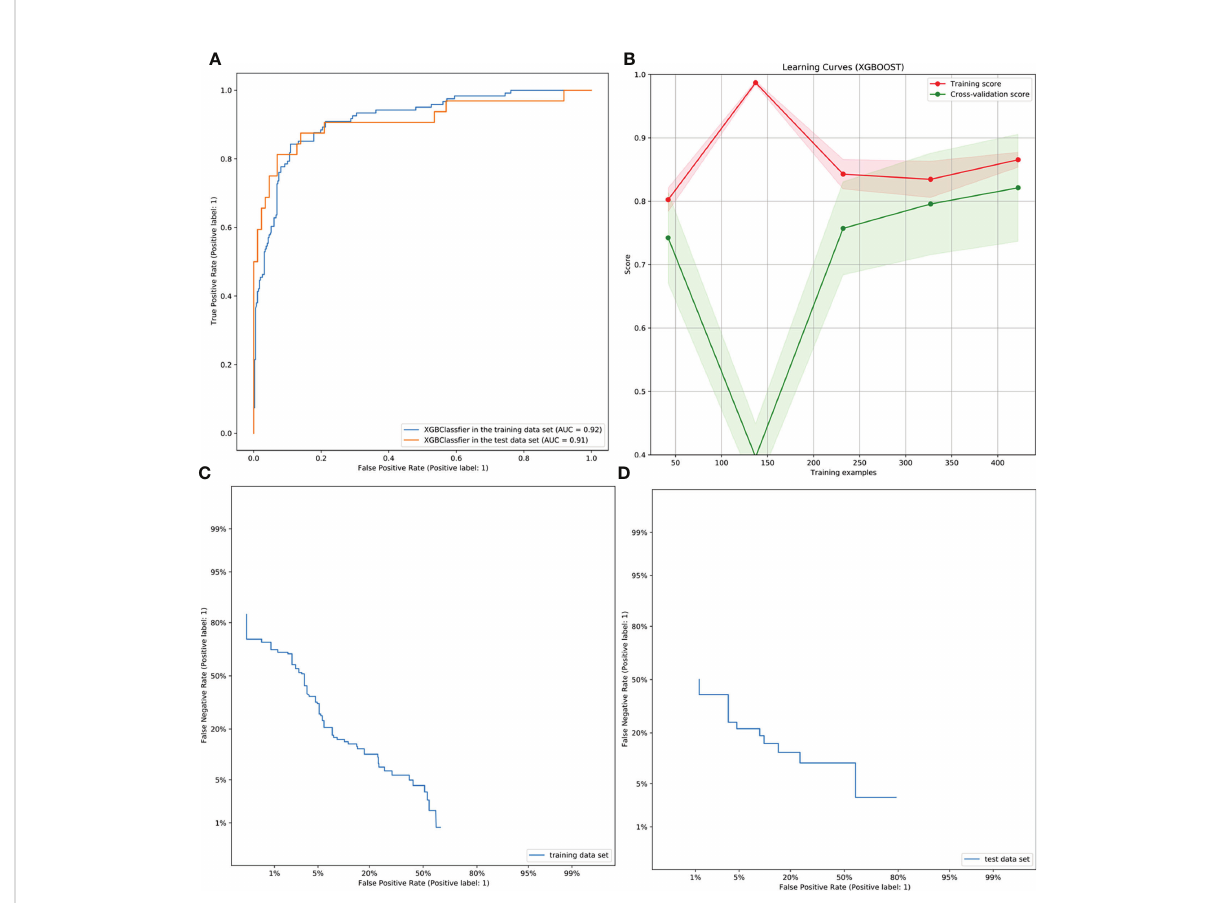
FIGURE 4 ROC, learning, and DET curves of the XBoost model. (A) The ROC curves of the XGBoost model in the training and test cohorts for predicting CCLNM in PTC patients, with an AUC of 0.9153 and 0.9088, respectively. (B) The learning curve in the training cohort of the XGBoost model. The two curves fi nally merge near 0.85, indicating that the model is well fi tted for training. (C, D) The DET curves of the XGBoost model in the training and test cohorts. They were both concentrated in the third quadrant, indicating that the false rejection rate and false acceptance rate were both